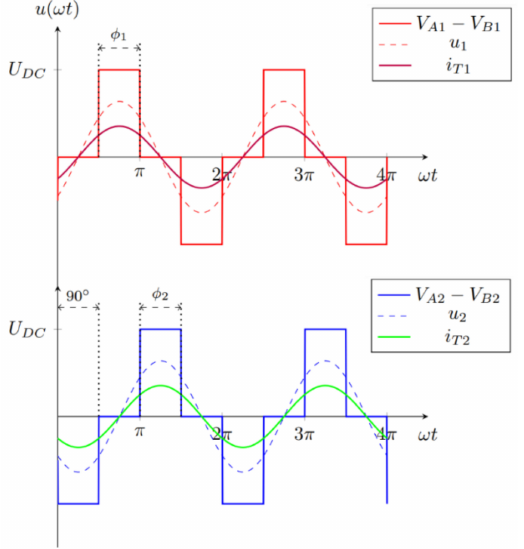
Figure 3. High-frequency inverter waveforms for excitation of DD1 and DD2 coils in a double DD transmitter coil